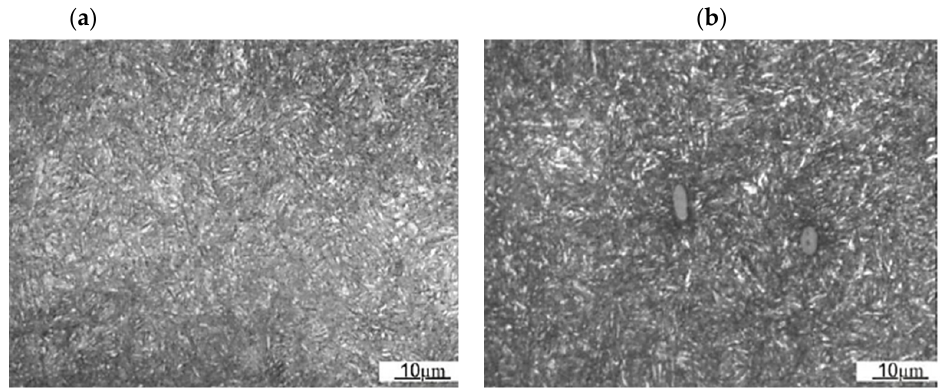
Figure 11. Microstructure of the tested forging die material: ( a ) area between bands, ( b ) area inside bands.